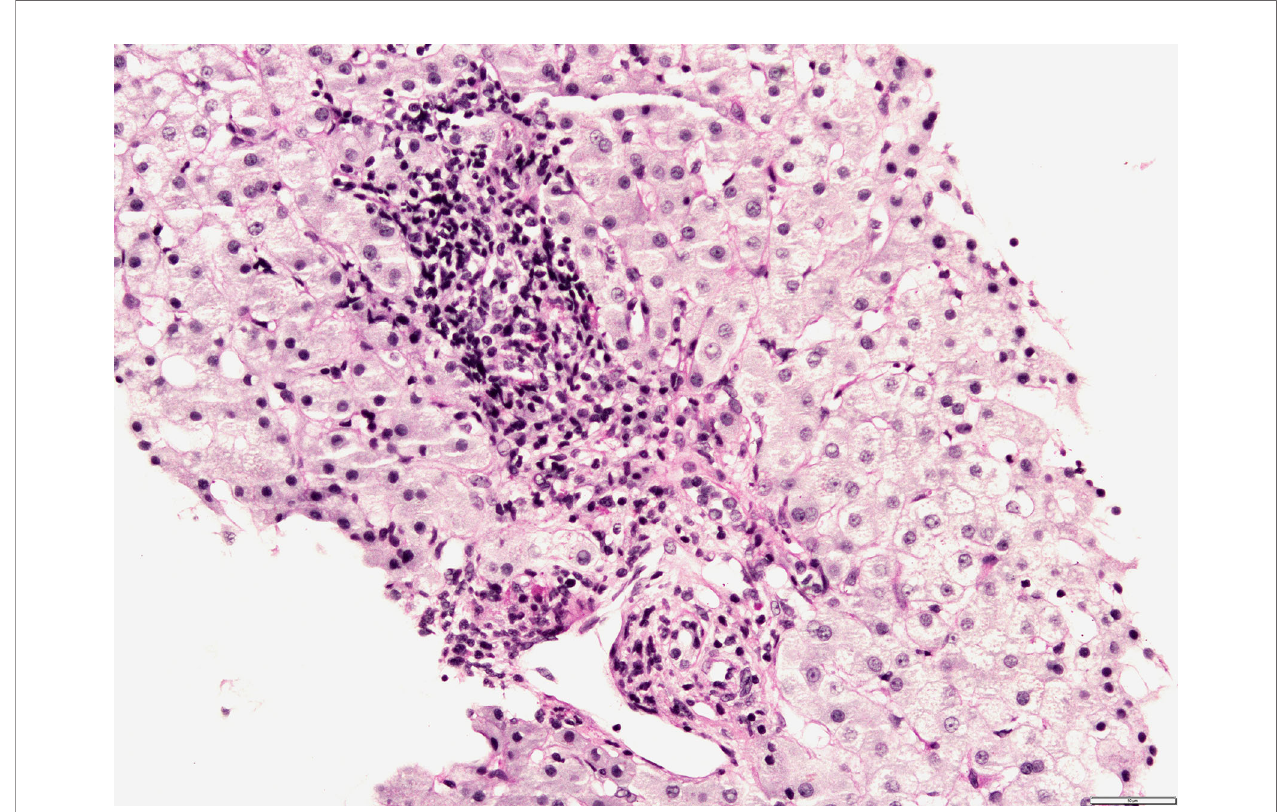
FIGURE 4 | Liver biopsy shows mononuclear in fi ltration of portal tract with focal interface hepatitis (PAS-D stain, magni fi cation 200x).